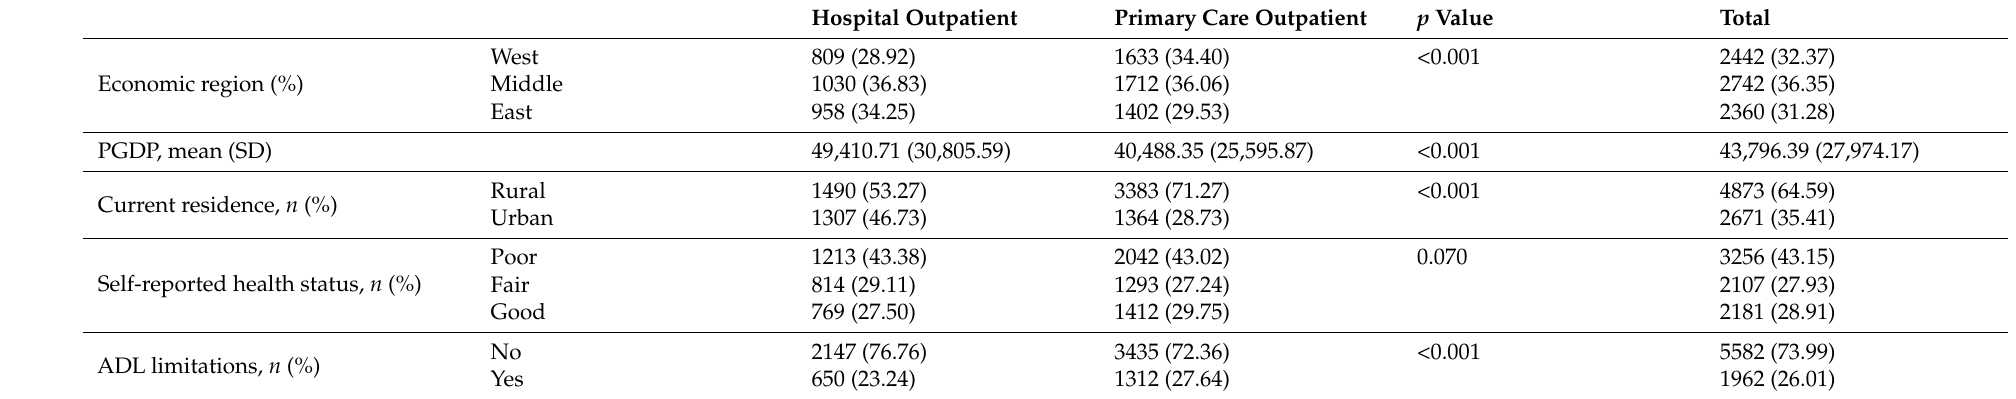
Table 2. Descriptive statistics of covariates in all four waves (N =